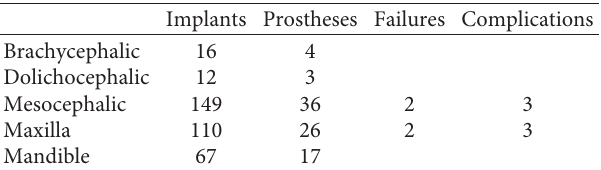
Table 2: Distribution of implants failures and complications be- tween